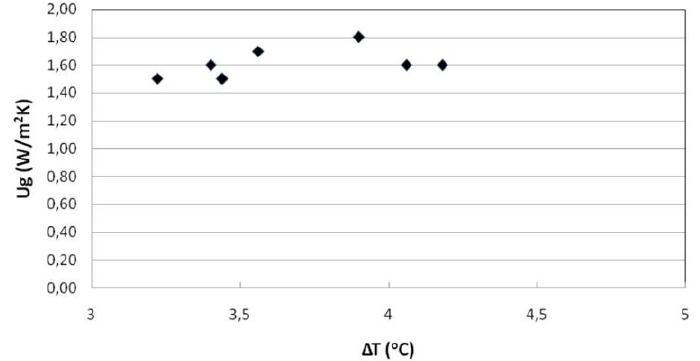
Figure 15. Variation of U g versus temperature difference ∆Îď . Scenario 2 .